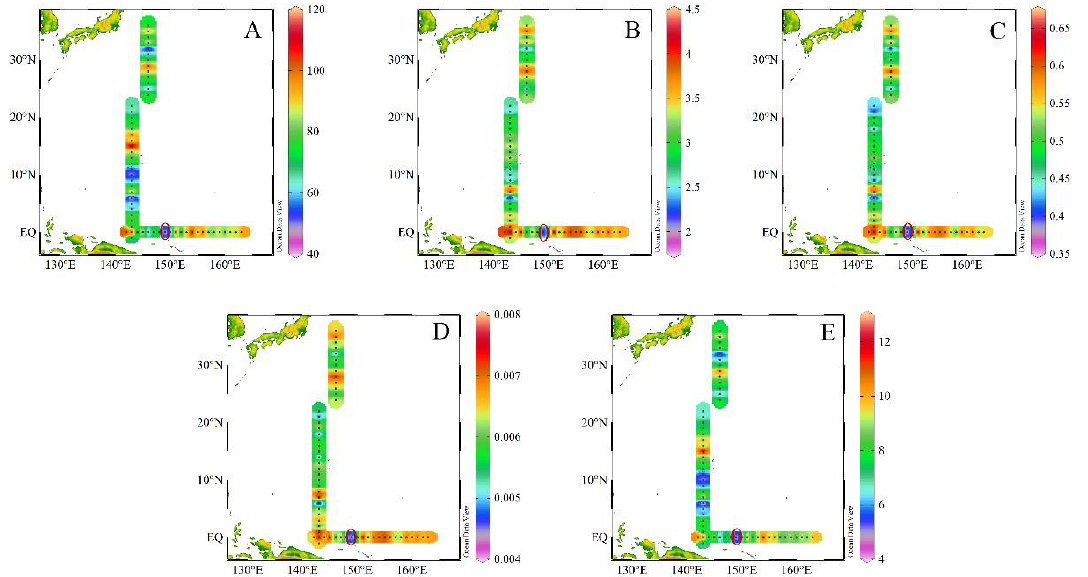
Figure 5. The horizontal distribution of zooplankton species diversity indices. ( A – E ) Species richness ( S ), Shannon–Wiener diversity index ( H′ ), Pielou’s evenness index ( J ), Simpson’s diversity index ( D ), and Margalef’s diversity index ( Dm ). The circled station stands for ST0315.